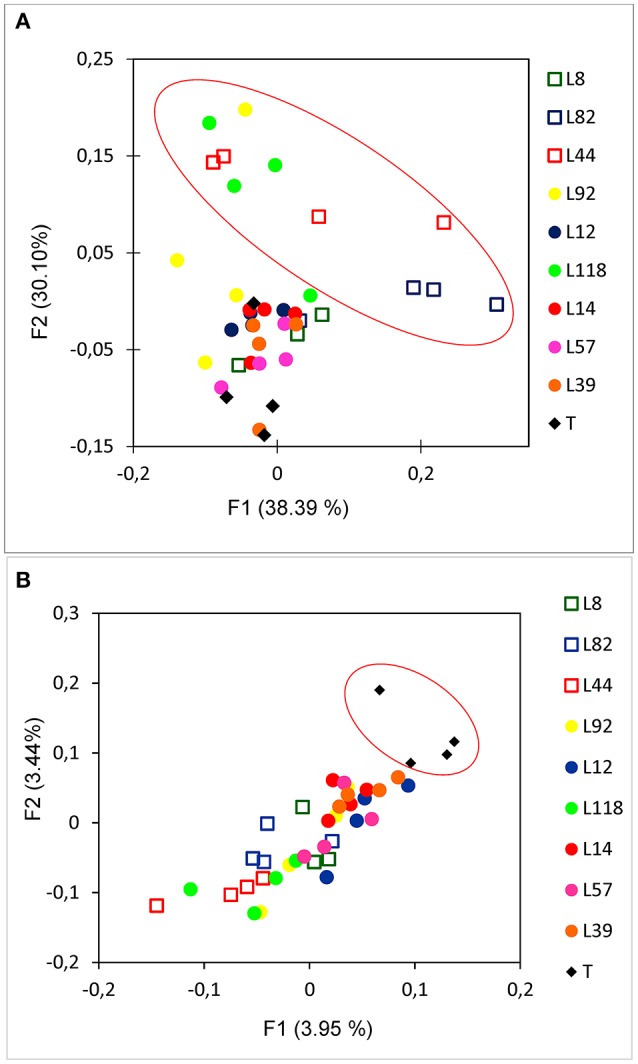
Principal Coordinate Analysis (PCoA) of weighted UniFrac (A) and Unweighted UniFrac (B) dispersion bacterial diversity of the 9 pearl millet inbred lines performed with 16S rRNA pyrosequencing. Low RAS/RT ratio lines are represented with square, high RAS/RT ratio lines are represented with circle.